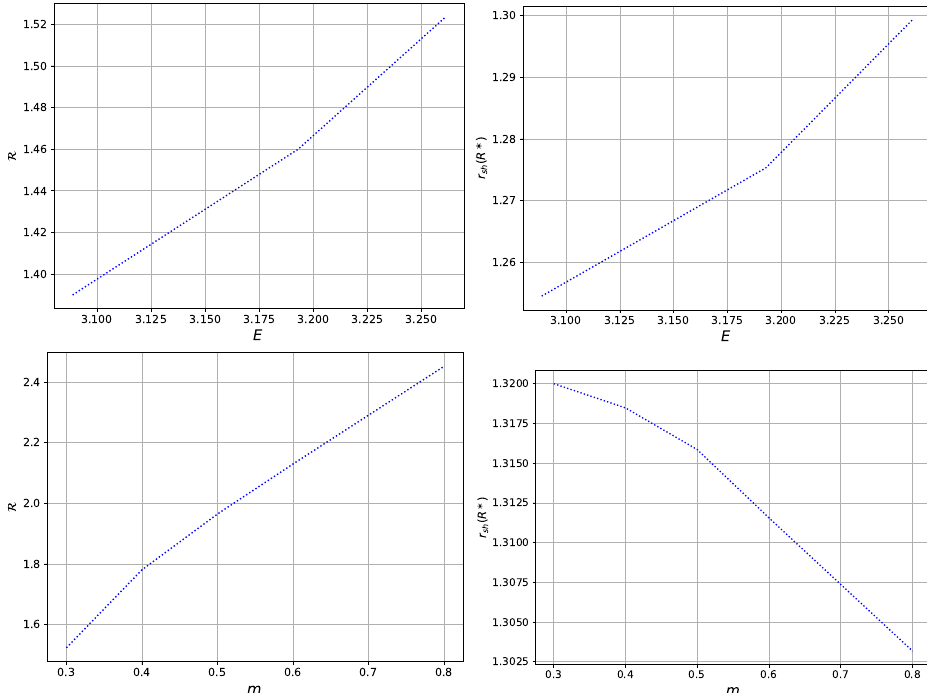
Figure 6. Variation of compression ratio R ( top left ) and shock location r sh ( top right ) with E for m = 0.3. Similarly R ( bottom left ) and r sh ( bottom right ) as functions of m keeping E = 3.26. For all these plots, ξ =